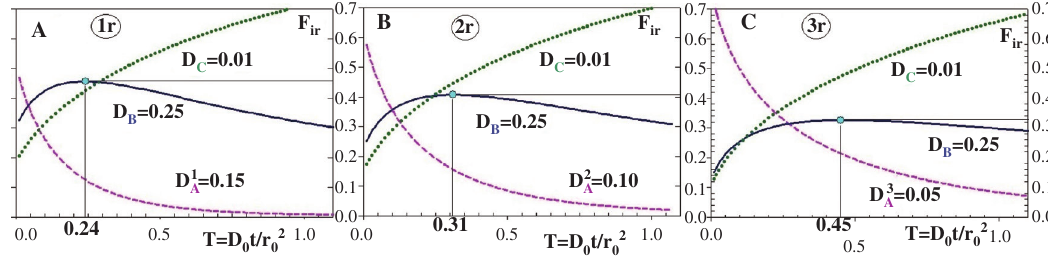
1-3 various, nonmonotonic F Figure 11 (A, B) D A